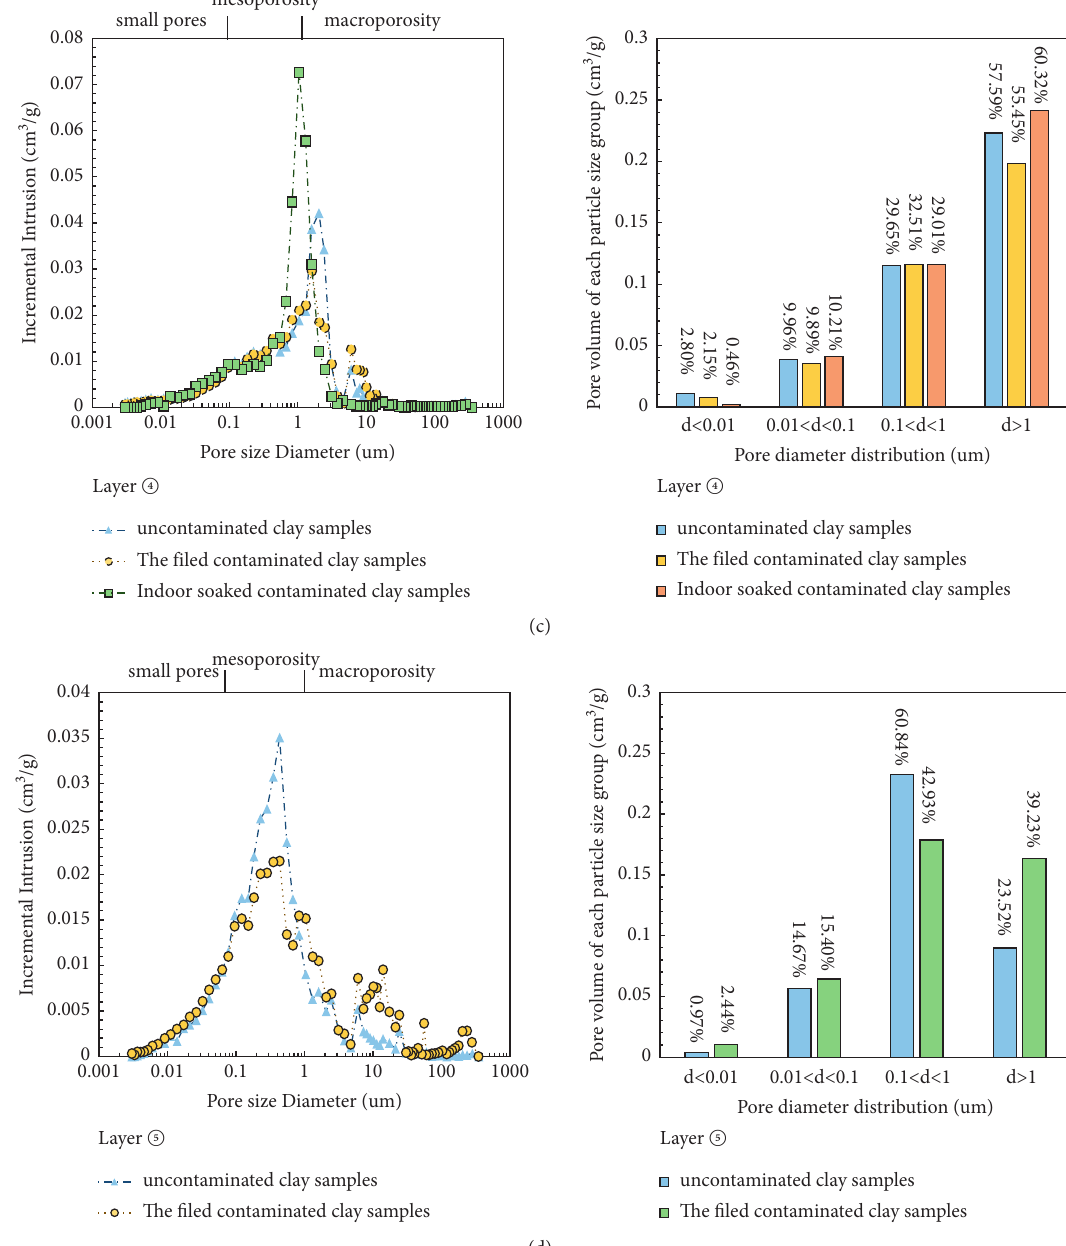
Figure 8: Pore size distribution of contaminated and uncontaminated samples. (a) Layer (2). (b) Layer (3). (c) Layer (4). (d) Layer